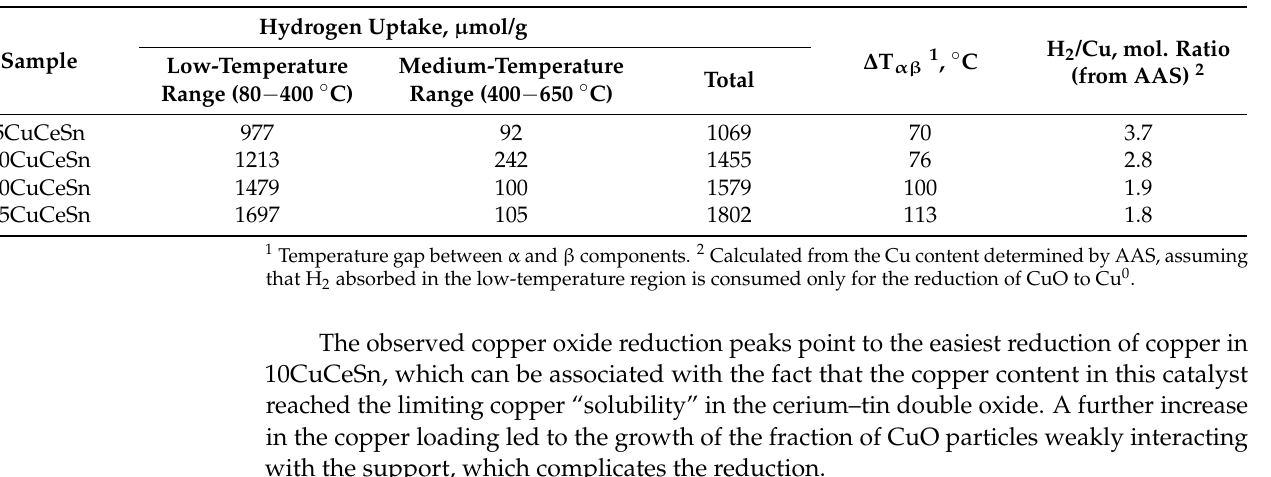
Table 3. H 2 -TPR results for CuCeSn catalysts with different Cu